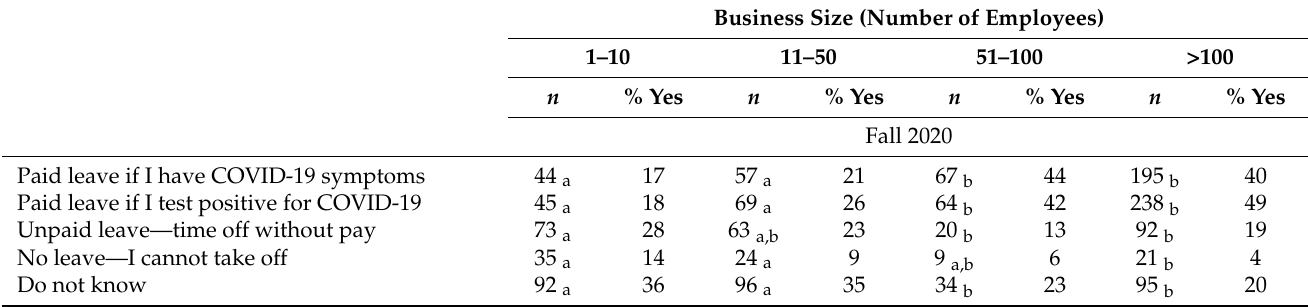
Figure 3. Respondent reported COVID-19 workplace mitigation scores (estimated marginal means, rounded to the nearest tenth) by industry, fall 2020 and fall 2021. Table 2. Leave Status by Business Size for Respondents Working Full or Part-time Outside the Home (Fall 2020) and Full or Part-time, Inside or Outside the Home (Fall of